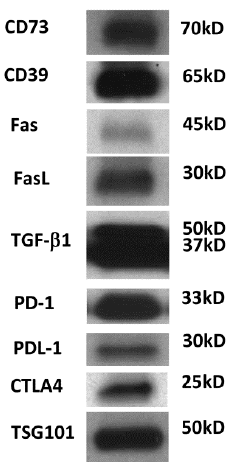
Figure 2. Western blot of TEX isolated from the supernatant of human acute myelogenous leukemia (AML) cell line (Kasumi-1) by miniSEC. TEX were concentrated by Viva Spin 300 and loaded onto SDS/PAGE gels always applying 10 µg protein /lane. Western blots were developed as previously described using antibodies specific for the inhibitory proteins [11]. Courtesy of Chang-Sook Hong (University of Pittsburgh Cancer Institute).